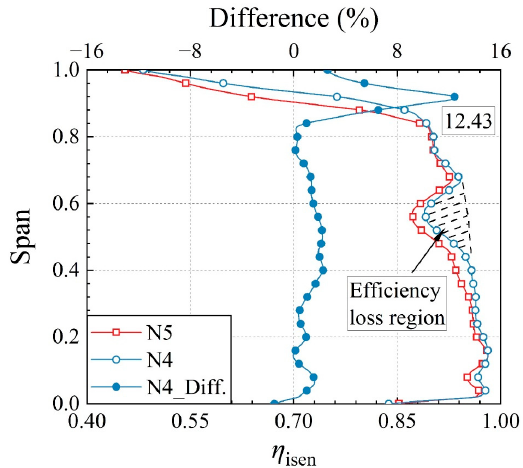
Figure 11. Spanwise distribution of η isen at the stage interface of N4 and N5.